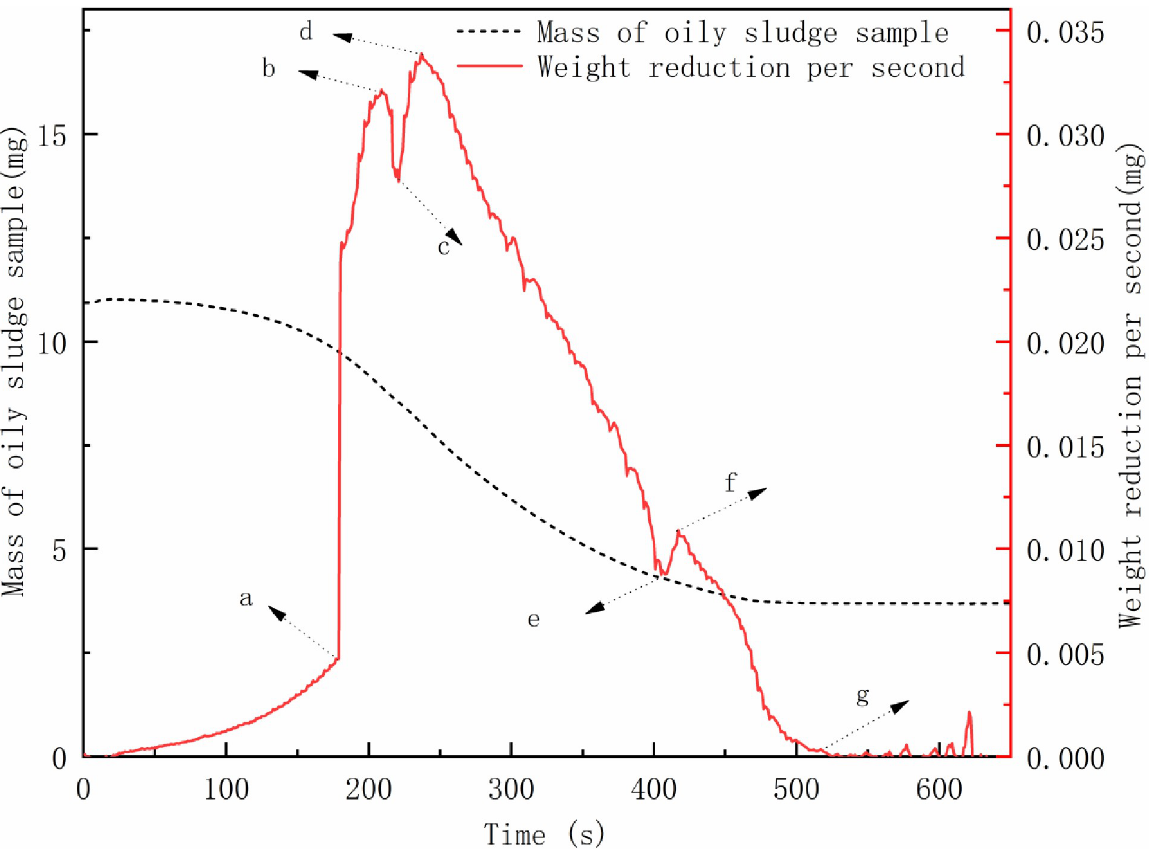
Fig 6. Evaporation curve of oily sludge sample (a, b, c, d, e, f, g are the typical inflection points for the evaporation rate).